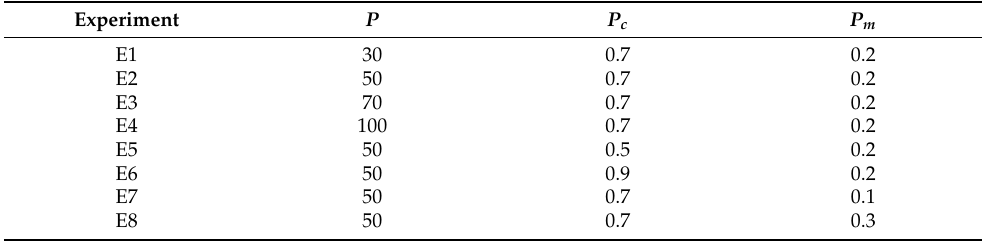
Table 2. Eight comparative experiments were performed to test the appropriate